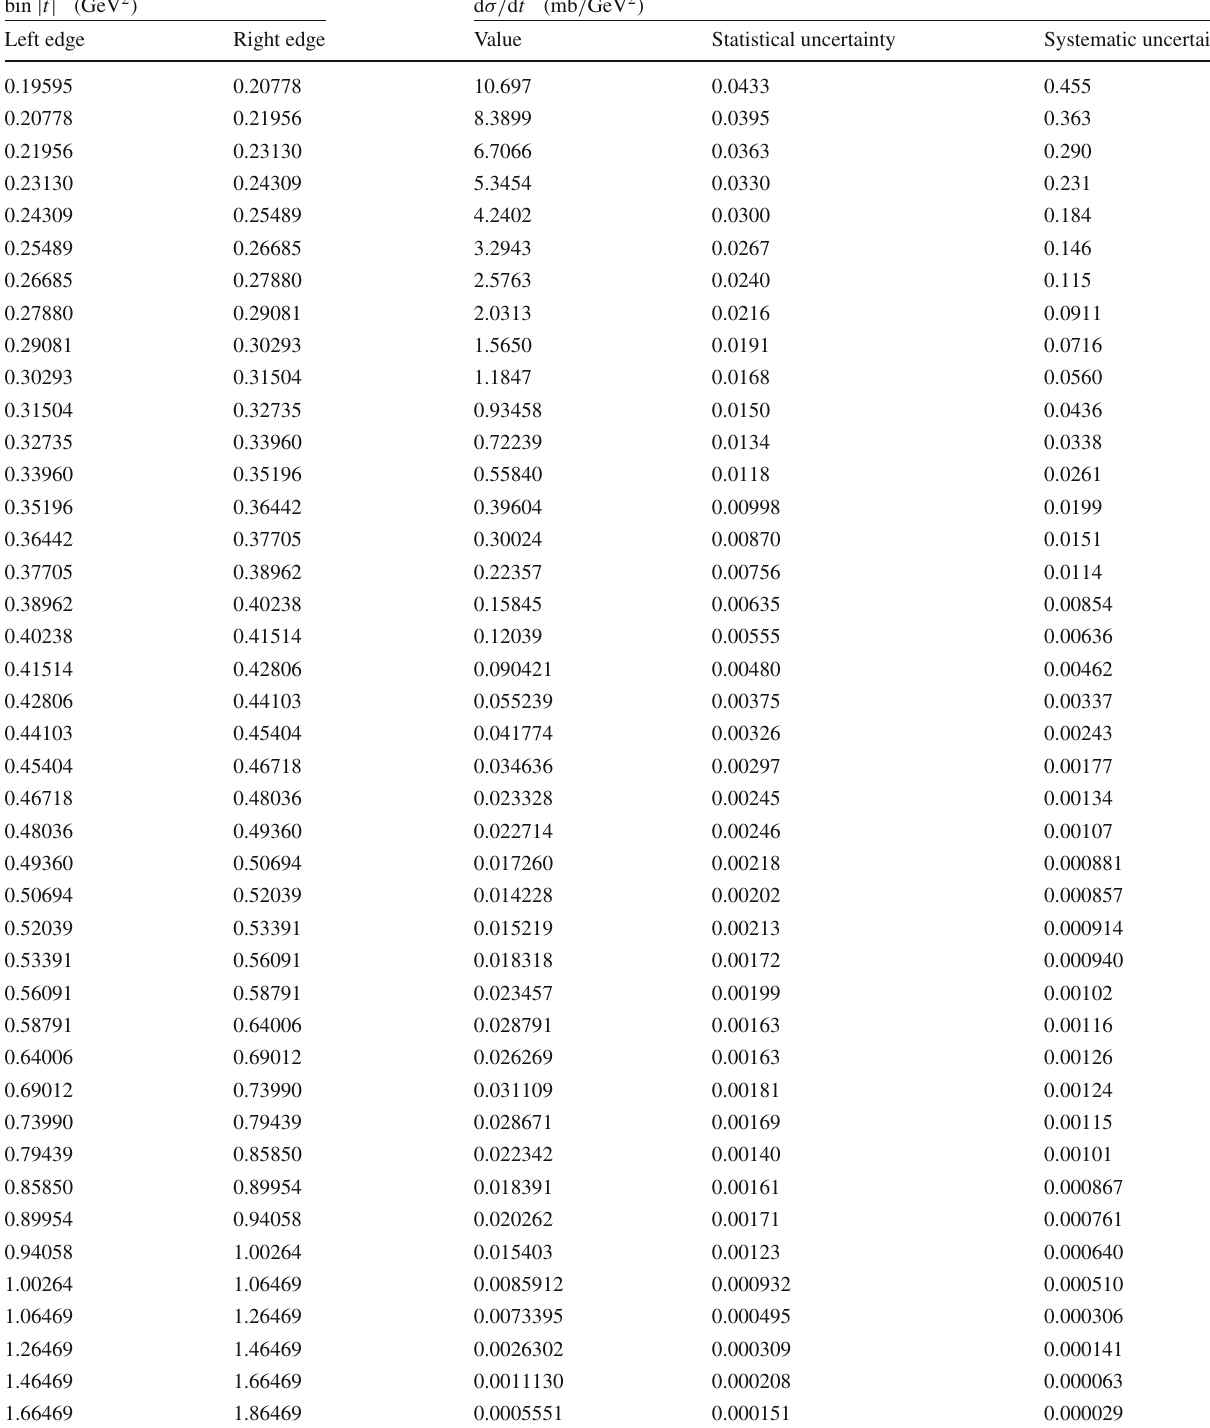
Table 1 Differential cross-section determined in the present analysis. The left-most two columns describe the | t | bin. The right-most three columns describe the differential cross-section value, statistical and systematic uncertainty bin | t | ( GeV 2